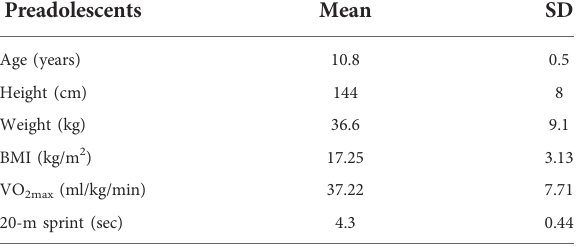
TABLE 1 Participants ’ characteristics ( N